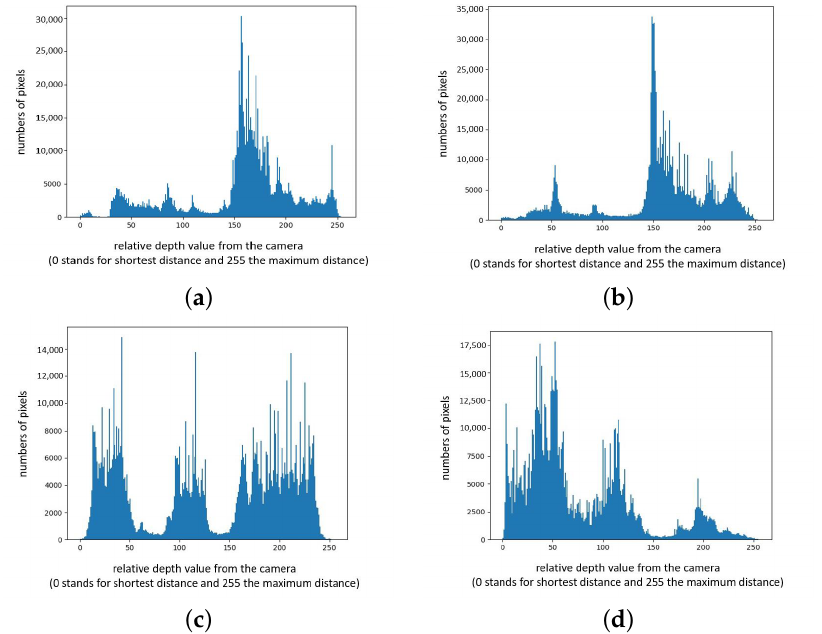
Figure 11. Image pair depth information histogram: ( a ) depth information histogram of image No. 25; ( b ) depth information histogram of image No. 26; ( c ) depth information histogram of image No. 191; ( d ) depth information histogram of image No.